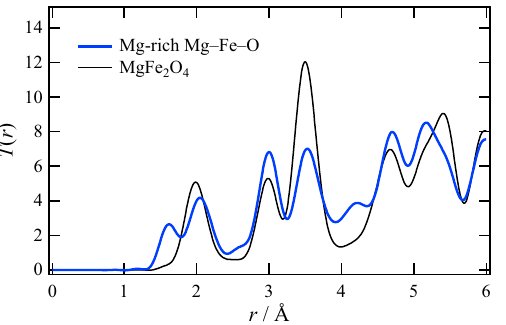
Figure 5. Total correlation function, T ( r ), of Mg-rich Mg–Fe–O. That of MgFe 2 O 4 with the spinel structure is also presented as a